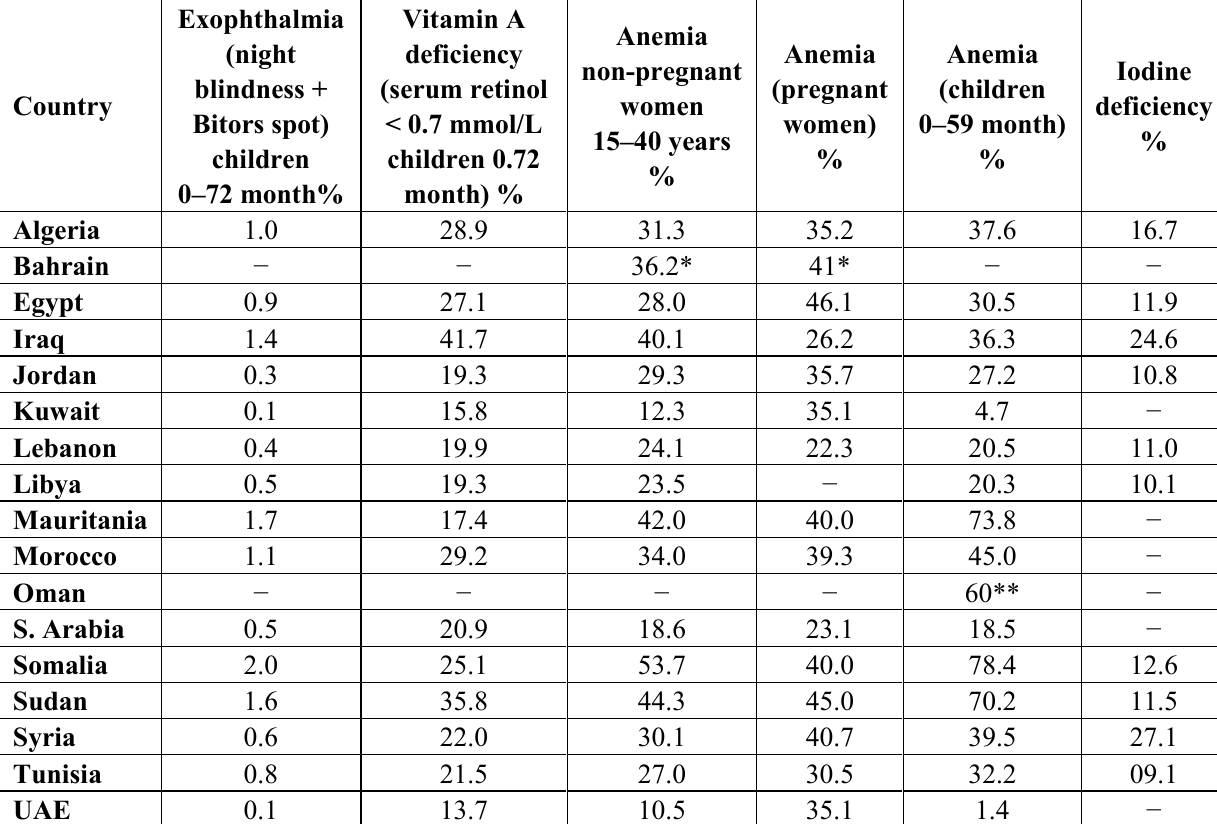
Table 2. Prevalence of micronutrient deficiency (vitamin A deficiency, anemia and Iodine deficiency) in the Arab countries